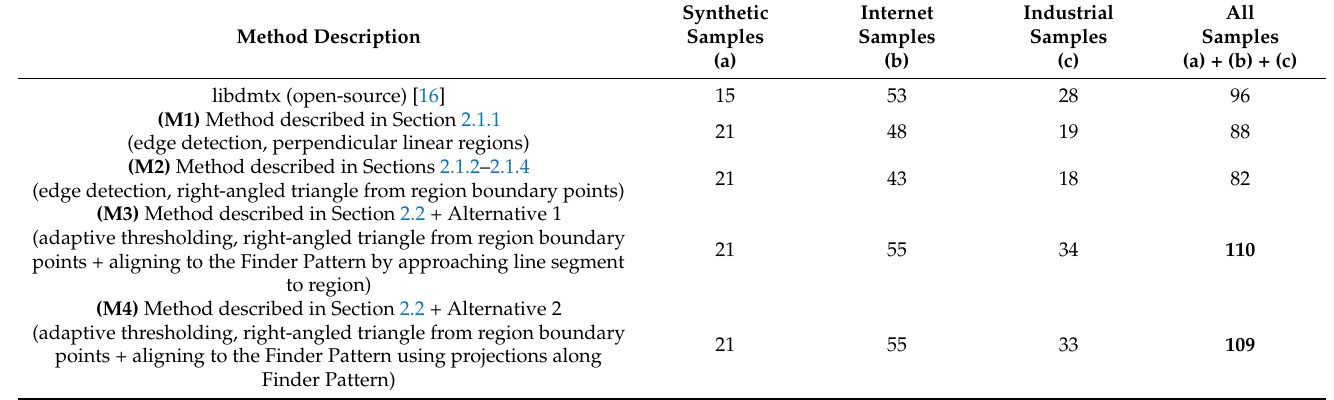
Table 2. Recognition results for different localization